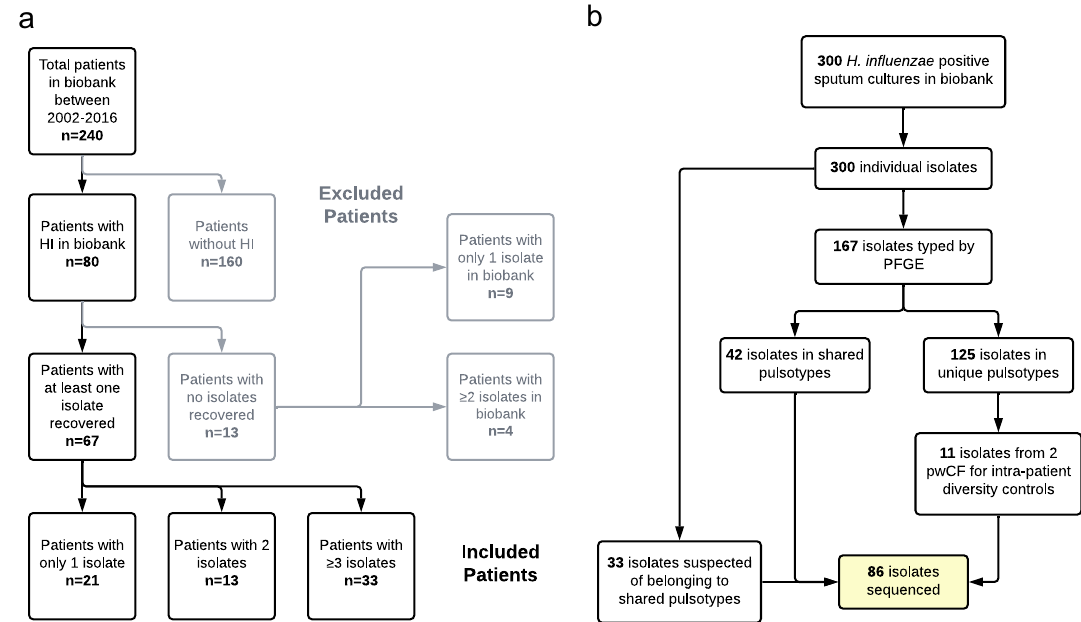
Figure 1. Flowcharts detailing ( a ) the breakdown of the number of included and excluded pwCF in the study and ( b ) the number of isolates at various stages of the study. In ( a ), the black and grey boxes/arrows/text indicate included and excluded patients, respectively. In ( b ), the yellow box indicates the endpoint of isolate selection for sequencing. The total number of isolates typed from the 67 included patients (black box 3 in ( a )) is 167 (box 3 in ( b